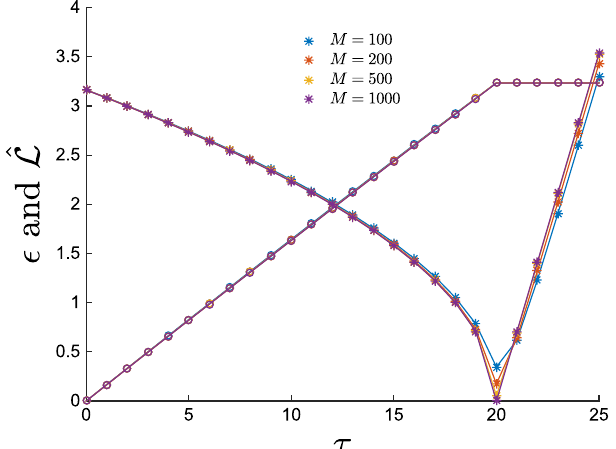
20 , N 1000 . 100, 200, 500, 1000 at β 2 , P = = = = 1000 , although we observe that even with very few =